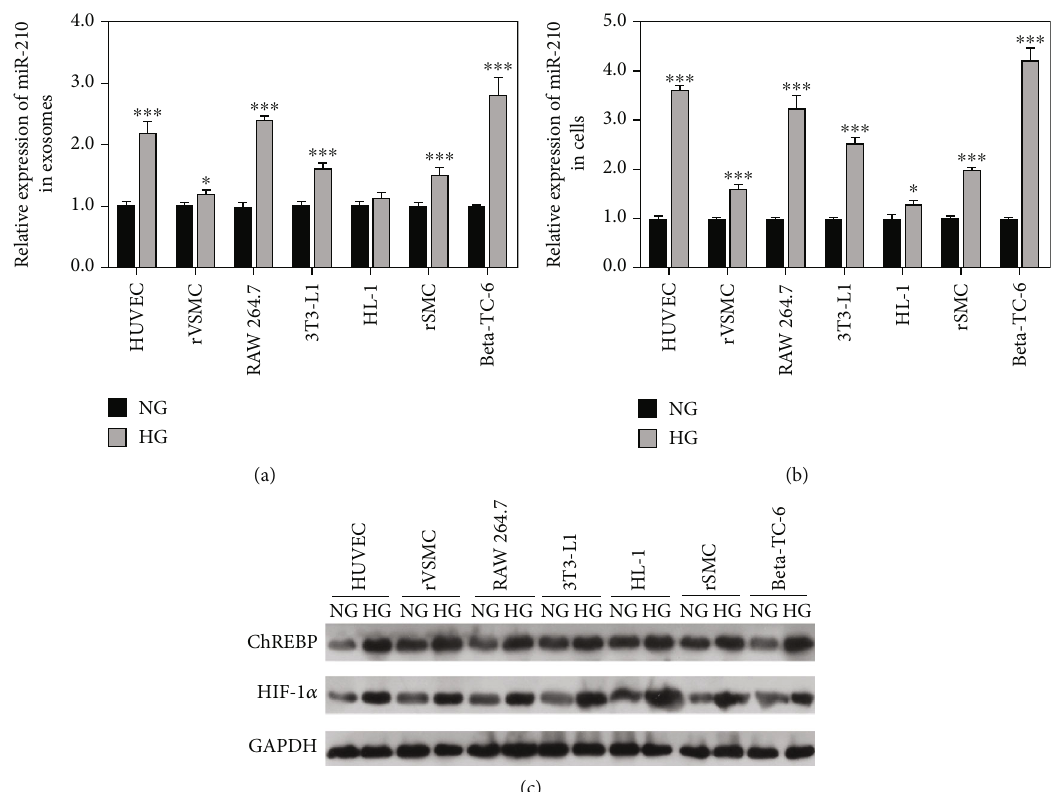
Figure 2: The exosomal miR-210 levels from cell culture supernatants and various cells after high glucose exposure. (a) The exosomal miR- 210 level from cell culture supernatants of human umbilical vein endothelial cells (HUVEC), vascular smooth muscle cells (VSMC), mouse mononuclear macrophages (RAW 264.7), mouse embryonic fi broblasts (3 T3-L1), mouse cardiomyocytes (HL-1), mouse skeletal muscle cells (SMC), and mouse insulinoma pancreatic β cells (Beta-TC-6) after high glucose exposure by qRT-PCR. (b) The miR-210 level of various cells after high glucose exposure by qRT-PCR. (c) The protein levels of carbohydrate responsive element binding protein (ChREBP), hypoxia-inducible factor 1 α (HIF-1 α ) in various cells after high glucose exposure by western blotting. ∗ P < 0 : 05 , ∗∗∗ P < 0 : 001 vs. normal group